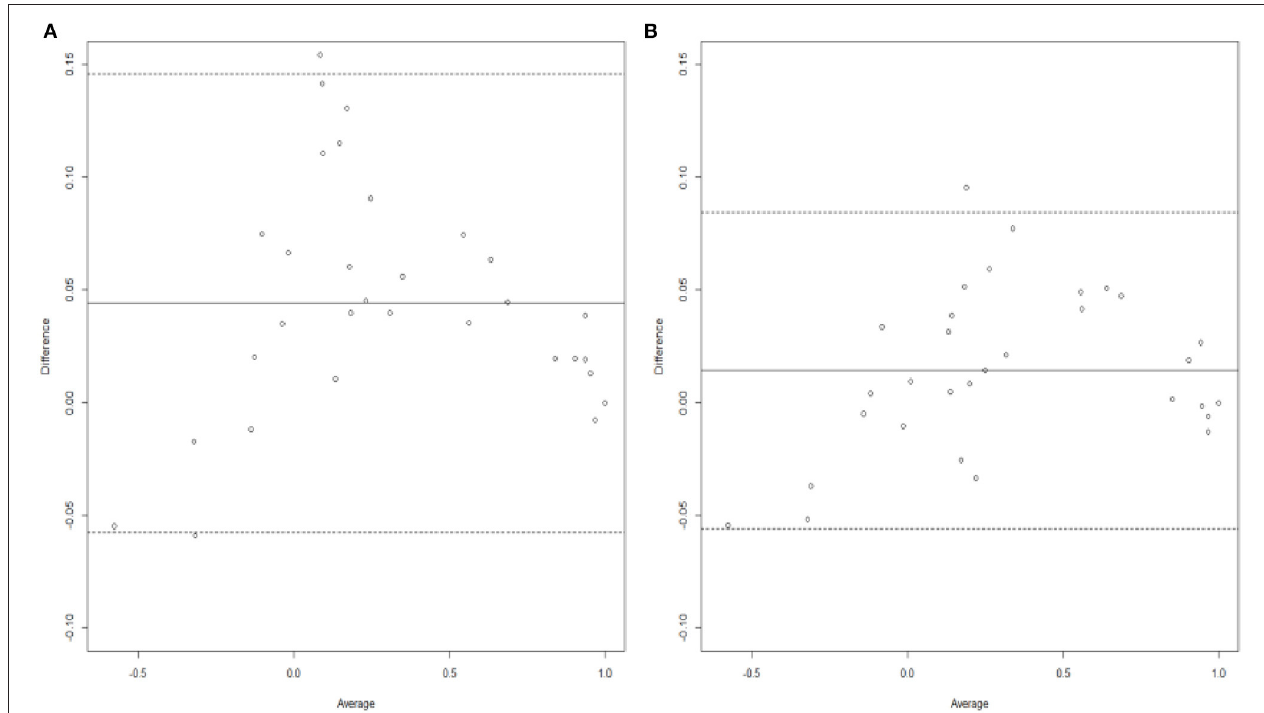
FIGURE 2 | Bland-Altman plots generated from analyzing (A) Irish data only and (B) Irish data with Polish results as informative